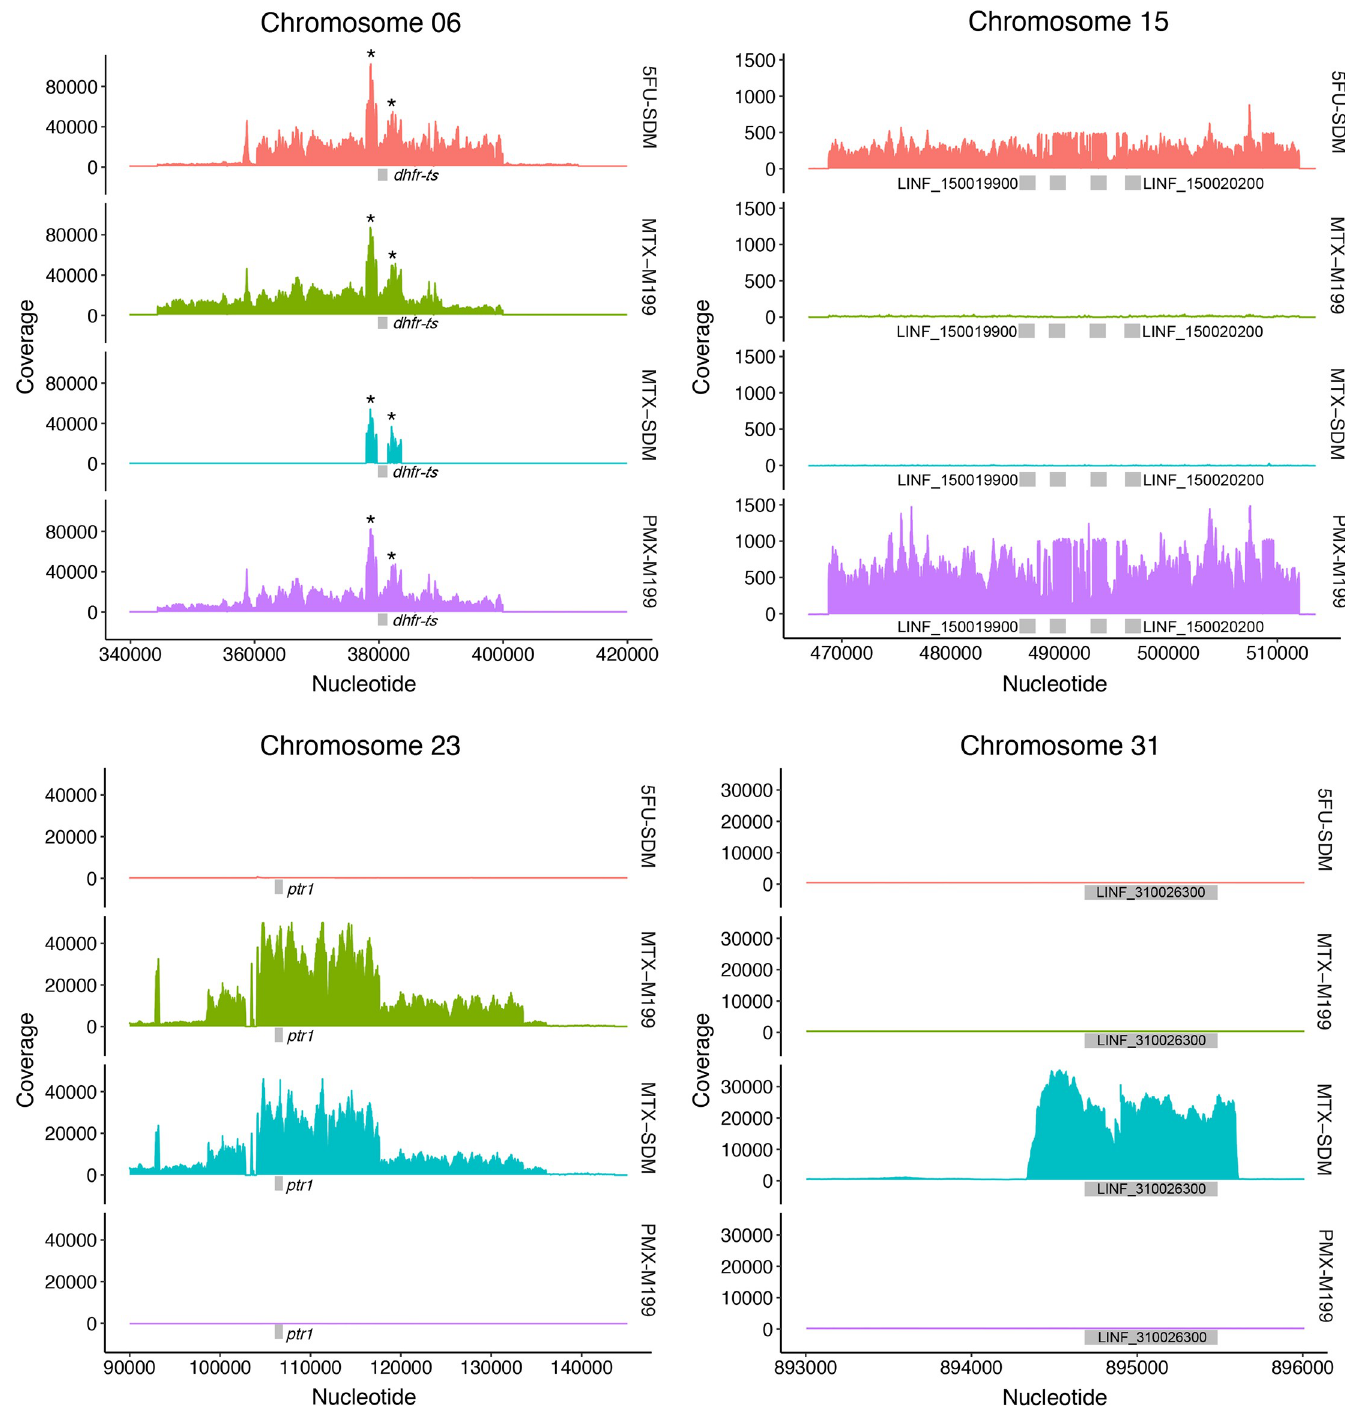
Fig 1. Cos-Seq identification of loci upon 5 fluorouracil (5-FU), methotrexate (MTX) and pemetrexed (PMX) selection. Visualization of the four enriched loci on chromosomes 6, 15, 23, and 31 as delimited by regions of higher read density. For LinJ.06, the asterisk denotes a bias in read counts coming from the DHFR-TS flanking regions originating from the cLHYG backbone [51]. The medium (M199 or SDM-79) in which the screen was done is also indicated. The key genes are shown with boxes and the full list of genes part of the enriched cosmids can be found in S2 Table.